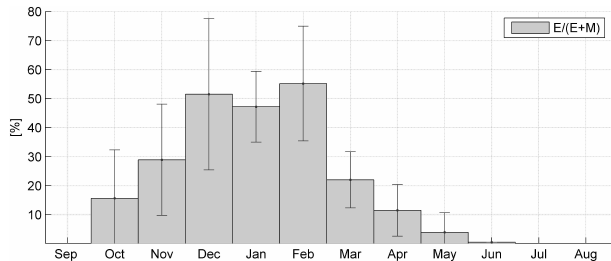
Figure 7. Mean monthly ratio of evaposublimation compared to to- tal ablation during the year at the Refugio Poqueira site for the study period 2008–2015. Whiskers represent standard deviation from the